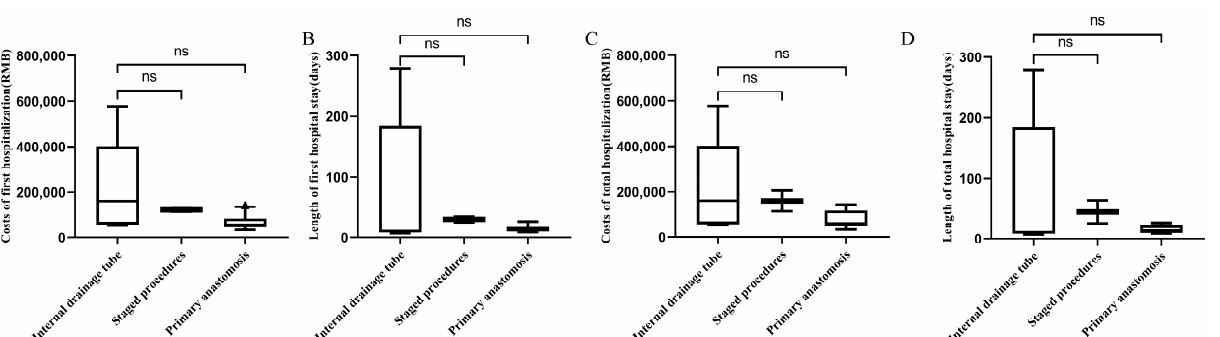
Figure 2. Lengths and costs of the first and total hospital stays for emergency patients. ( A ) Costs of the first hospitalization; ( B ) length of the first hospital stay; ( C ) costs of total hospitalization; ( D ) length of total hospitalization. ns: p > 0.05.